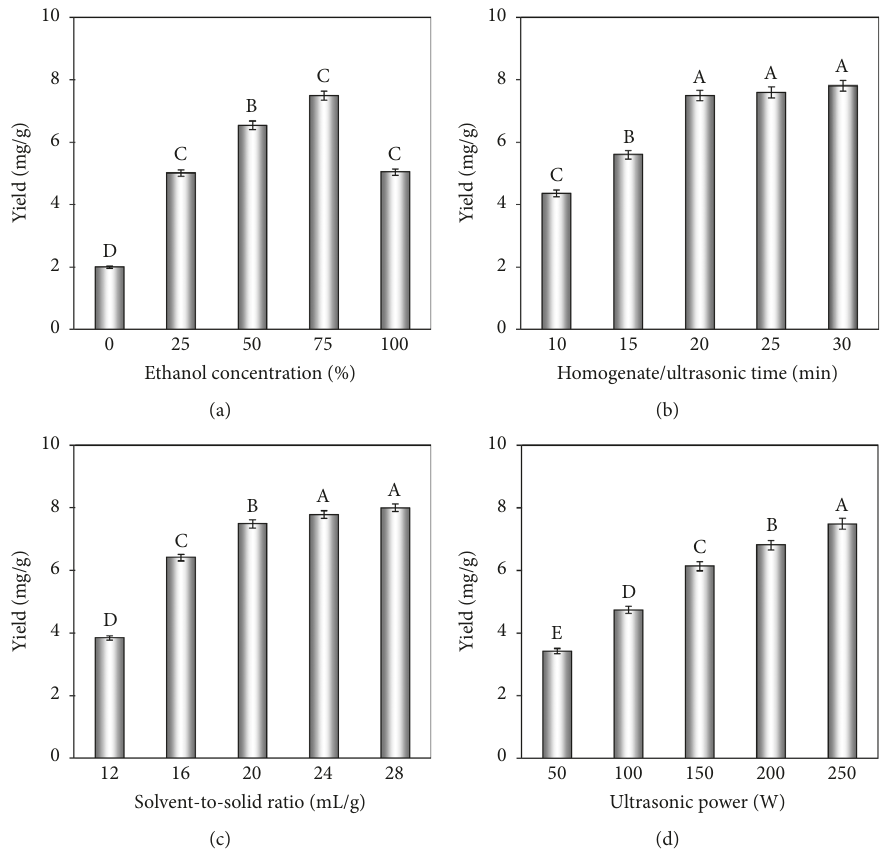
Figure 1: Effect of ethanol concentration (a), homogenate/ultrasonic time (b), solvent-to-solid ratio (c), and ultrasonic time on the flavonoids yield from C. camphora leaves